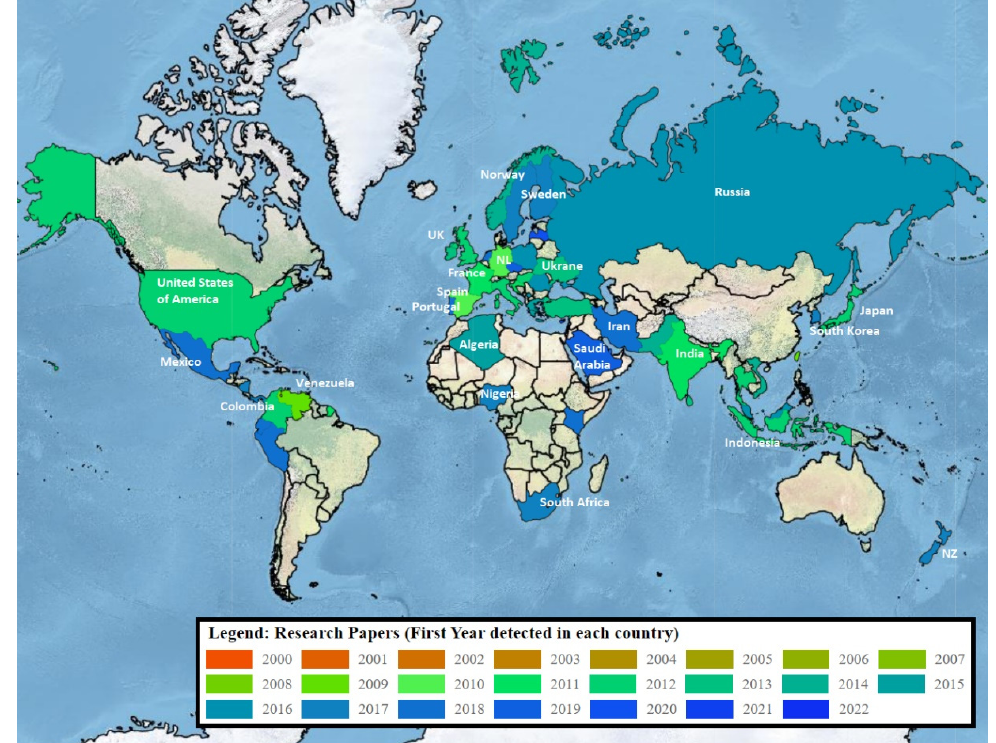
Figure 12. First occurrence of SOA by country, shown on a map backdrop.